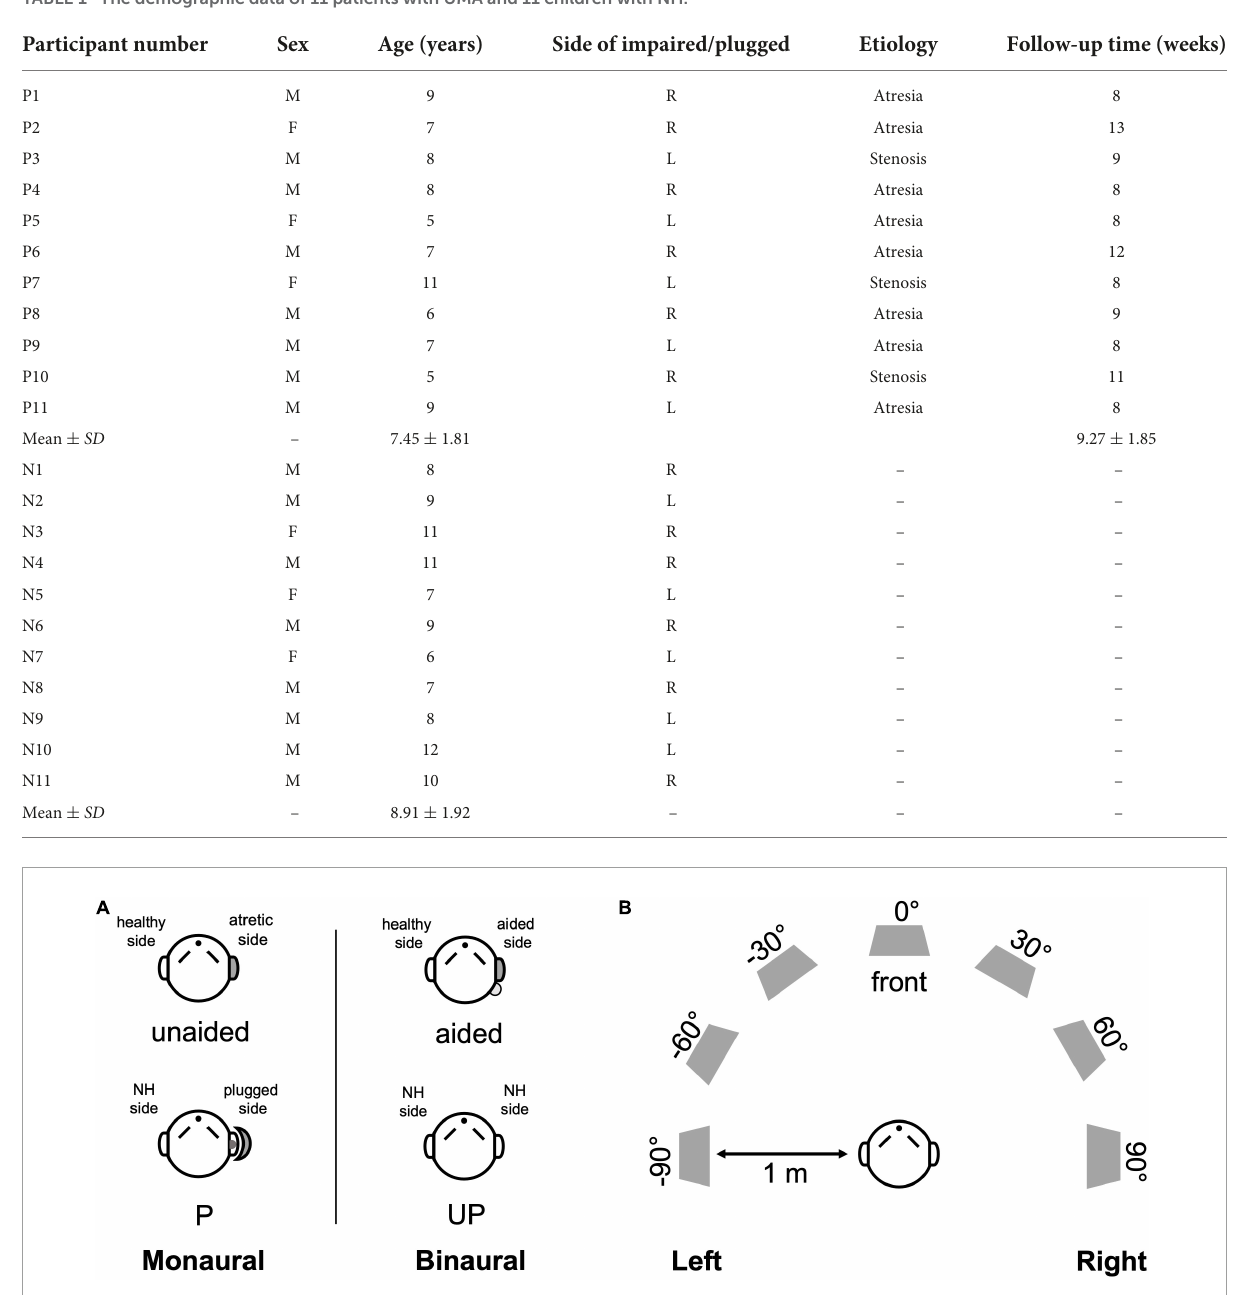
FIGURE1 Test setup and listening conditions. (A) The monaural (left) and binaural listening (right) conditions are designed for UMA patients (unaided and aided conditions) and controls (P and UP conditions). (B) Seven loudspeakers were placed at 30 ◦ intervals in a semicircle in a double-walled, soundproof laboratory. NH, normal hearing; P, the plugged condition; UP, the unplugged condition.